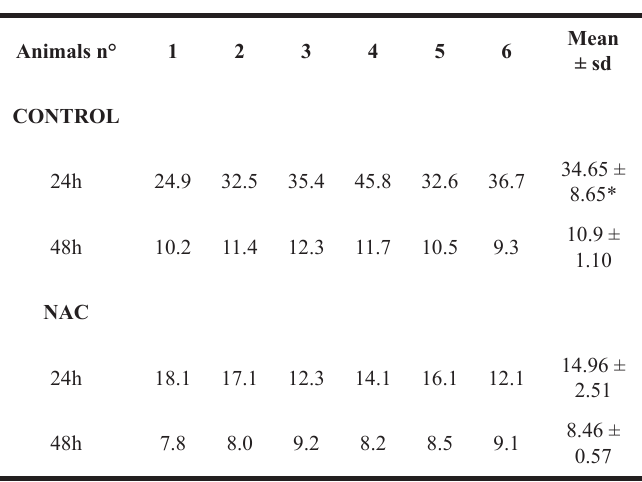
TABLE 4 - Distribution of the mean ± standard deviation of the expression of caspase 3 (apoptosis) in lung parenchyma for each animal in each group of 1000 cells counted in 20 random fields in the slides stained by immunohistochemistry. ANOVA Test (p<0.05).